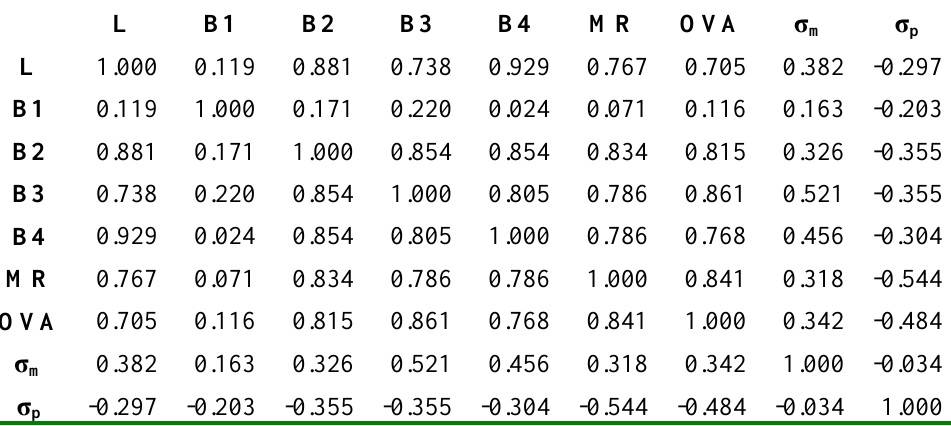
Table 3. Correlation Matrix of the chosen QSAR